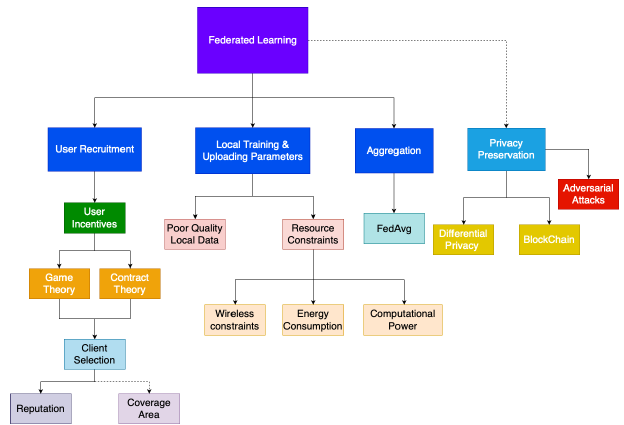
Figure 5. Proposed Taxonomy for Federated